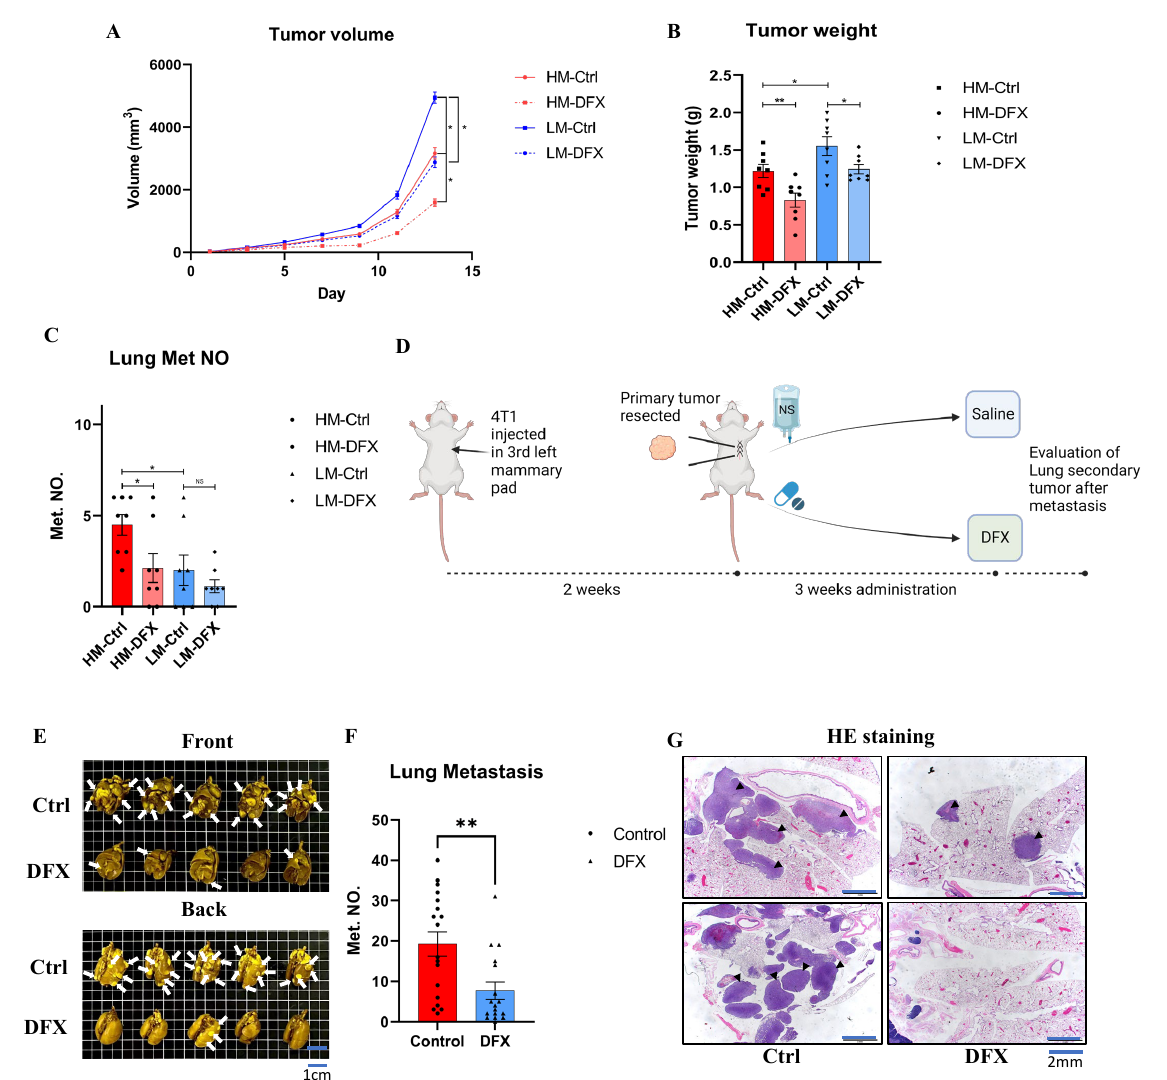
Figure 7. DFX inhibits the growth of 4T1–LM, 4T1–HM, and 4T1 primary and lung metastatic tumor in vivo. ( A ) 4T1–LM (1 × 10 5 ) and 4T1–HM cells (1 × 10 5 ) were injected in left mammary gland of BALB/c female mice (6–8 weeks old). After 7 days, each group of mice were randomly divided into two groups ( n = 8), and treatment was initiated as indicated. DFX and Ctrl treated groups were treated with 160 mg/kg DFX or equivalent volume of saline via oral gavage. Tumor volume was measured. The Student’s t test was utilized to compare two groups, * p < 0.05 and Data shown as the mean ± S. E. M. ( B ) Tumor weight was measured in the end of study. DFX effectively decreased tumor weight. Tumor volume was measured. The Student’s t test was utilized to compare two groups, * p < 0.05 and ** p < 0.01, and Data shown as the mean ± S. E. M. ( C ) Lung tissue were collected, and metastatic tumor numbers were counted under stereomicroscope. Tumor volume was measured. The Student’s t test was utilized to compare two groups, * p < 0.05. and Data shown as the mean ± S. E. M. ( D ) Diagram shows the experimental model mimicking treatment for lung metastasis after surgical resection of primary tumor. 4T1 cells (1 × 10 5 ) were injected in left mammary gland of BALB/c female mice (6–8 weeks old). After 2 weeks, primary tumors were resected and randomly divided into two groups (DFX: n = 18; Saline Ctrl: n = 17). DFX and Ctrl treated groups were treated with 160 mg/kg DFX or equivalent volume of saline via oral gavage for 3 weeks. ( E ) Lung tissues were collected